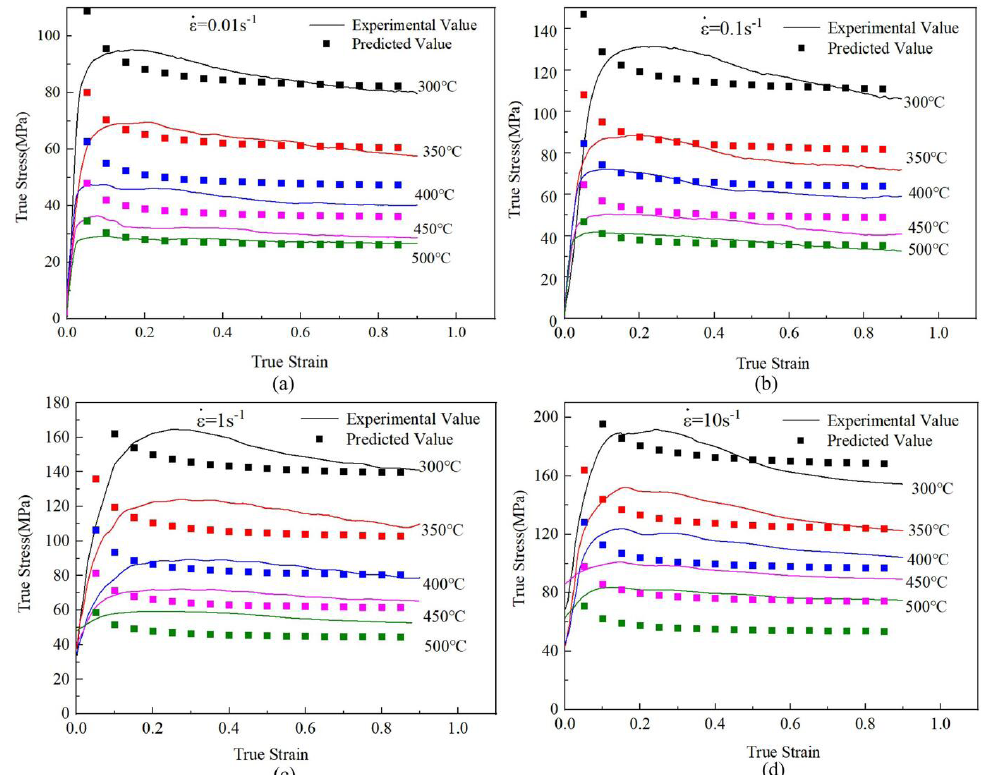
Figure 6. The comparison between predictions of constructed Johnson-Cook model and experimental